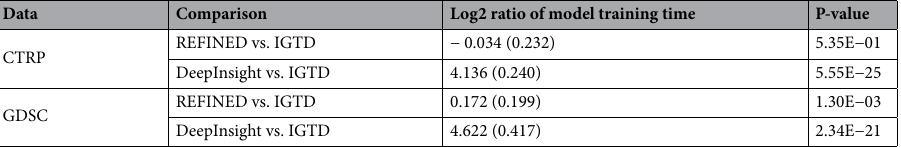
Table 3. Comparison on model training time of CNNs trained with different image representations. The number before parenthesis is the average across 20 cross-validation trials, and the number in the parenthesis is the standard deviation. P-value is obtained via the two-tail one-sample t-test across the cross-validation